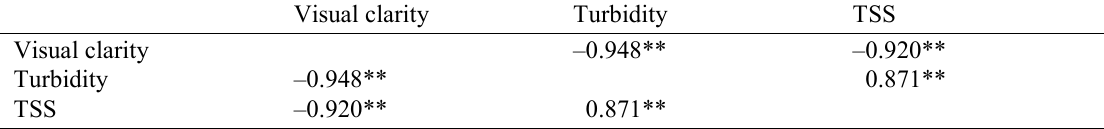
Fig. 1 Scatterplot of TSS vs visibility for data for 12 months across all 77 sites. Table 1 Correlations between optical variables; ** indicates a significant correlation at the 99%